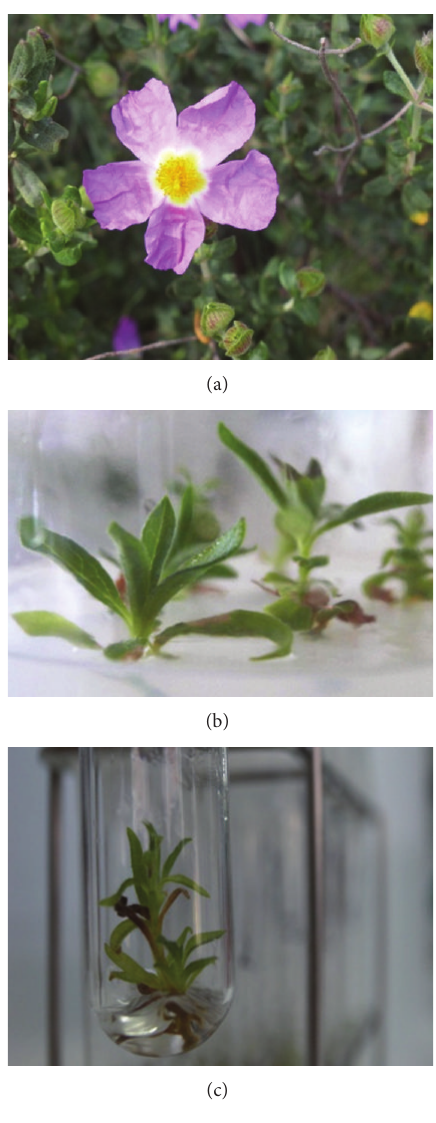
Figure 1: Micropropagation of Cistus heterophyllus from an adult plant. (a) Detail of a mature field-grown plant in June. Shoots developed on gelled-MS/2 (b) and liquid MS/2 media